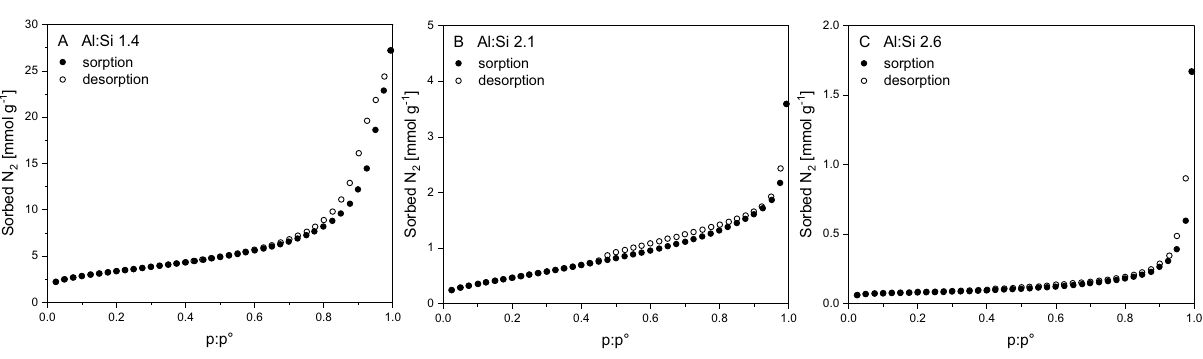
Figure 6. Nitrogen sorption and desorption isotherms at − 196 °C of cryomilled short-range ordered aluminosilicates with varying Al:Si ratios ( A 1.4; B 2.1; C